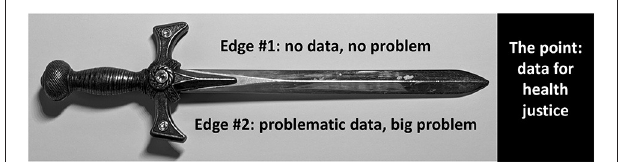
FIGURE 1 | Structural injustice and the two-edged sword of data: (1) Edge #1 : preventing documentation that injustice exists, (2) Edge #2 : using problematic data in harmful ways that further entrench justice, vs. (3) looking instead to the point: data for health justice. [Note: the author created the figure and took the photo used; NO copyright issues are